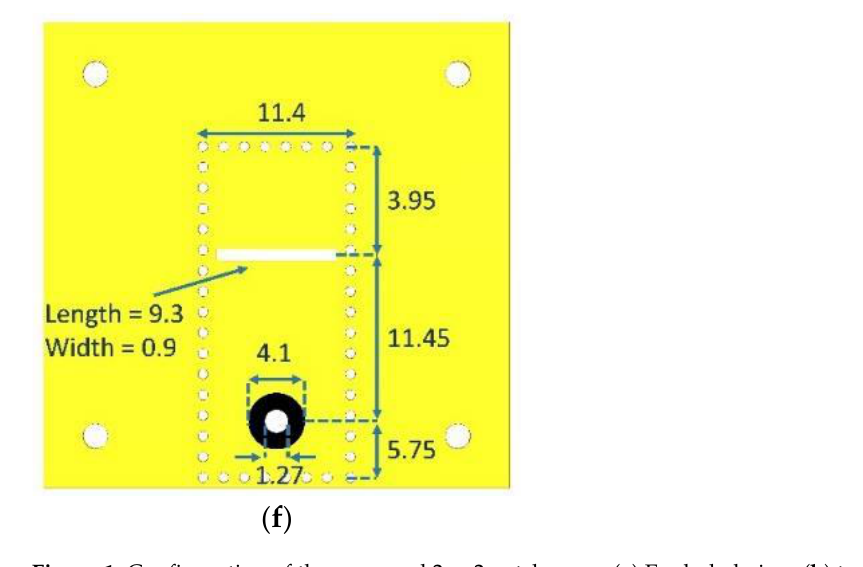
Figure 1. Configuration of the proposed 2 × 2 patch array. ( a ) Exploded view, ( b ) top view, ( c ), back view, and top views of the ( d ) top layer, ( e ) middle layer, and ( f ) bottom layer.